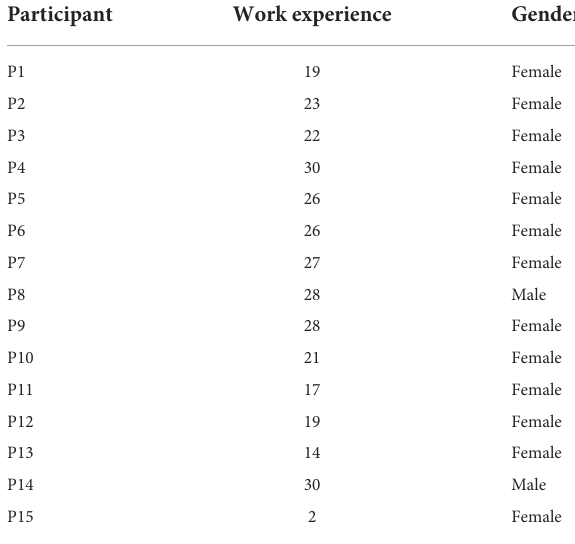
TABLE 1 Participant